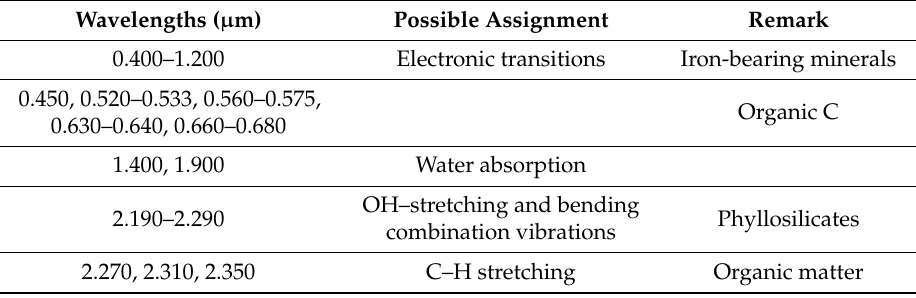
Table 8. Band assignments of identified VIS–NIR–SWIR wavelengths (these were compiled from [45,46]). Wavelengths ( µ